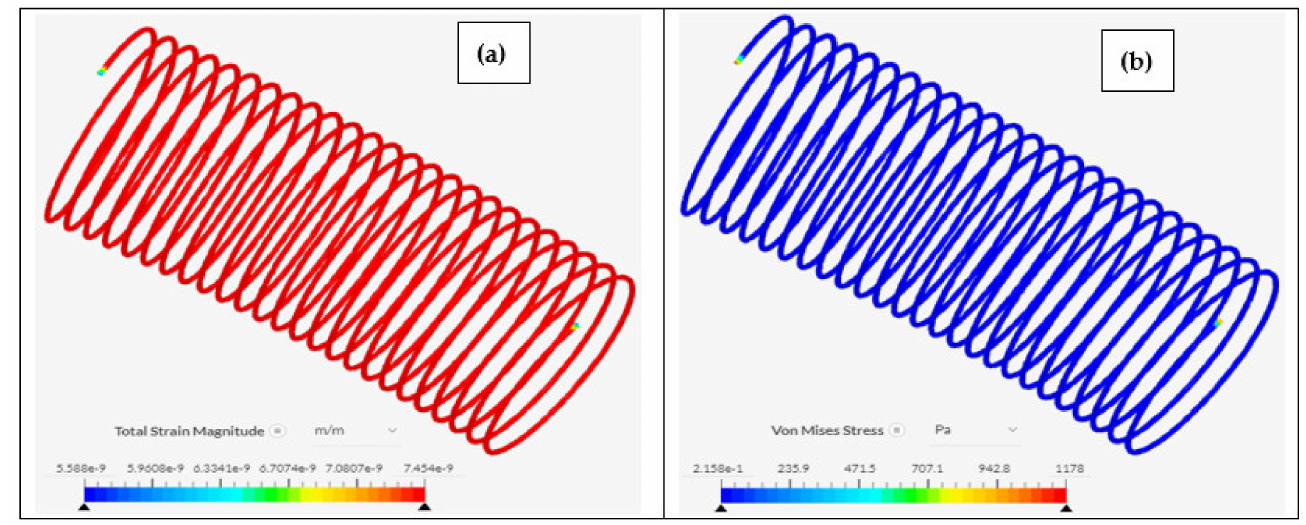
Figure 11. Reinforcement helix for the bonded flexible hose under loading, showing ( a ) strain magnitude, and ( b ) von Mises stress, as carried out in Simscale